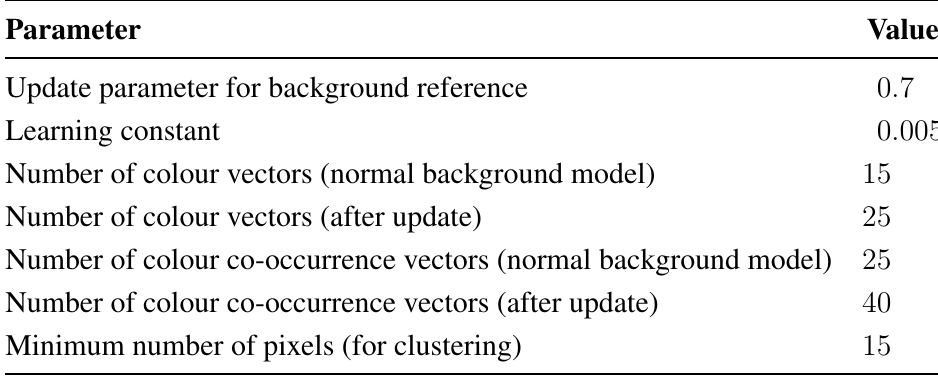
Table 2. Parameters used for colour co-occurrence background